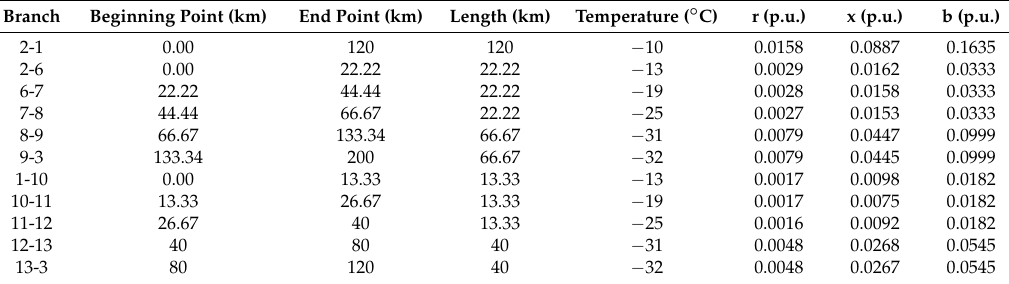
Table 8. The temperatures and the parameters of each branch after segmentation.